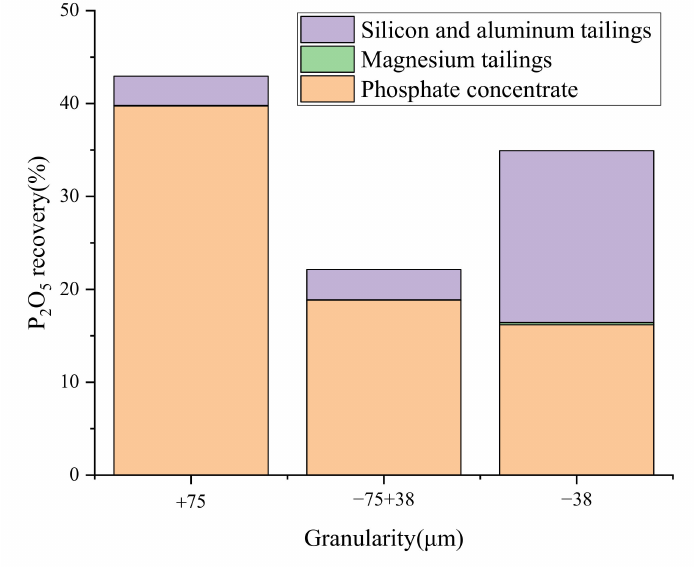
Figure 15. Relationship between particle size of each product after flotation and P 2 O 5